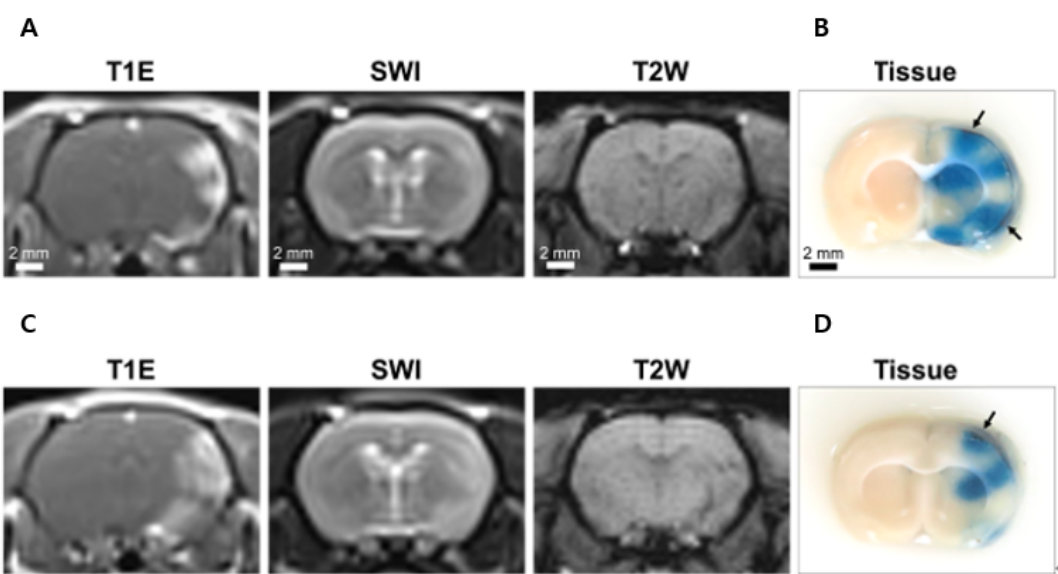
Figure 6. Representative magnetic resonance (MR) images and Evans blue dye-stained brain sections after FUS-induced the BBB opening in rats. ( A ) BBB opening MR result without the human skull for 300 mV input voltage. T1E MR confirmed the BBB opening. T2W and susceptibility-weighted imaging (SWI) MR images were used to evaluate edema and cerebral microhemorrhages, respectively. ( B ) Evans blue dye-stained tissue image confirmed the BBB opening and extravasated red blood cells (RBCs). ( C ) BBB opening MR images and ( D ) Evans blue dye-stained tissue image with the human skull for 700 mV input voltage. Note that areas where a small amount of RBCs were visible are indicated by black arrows.